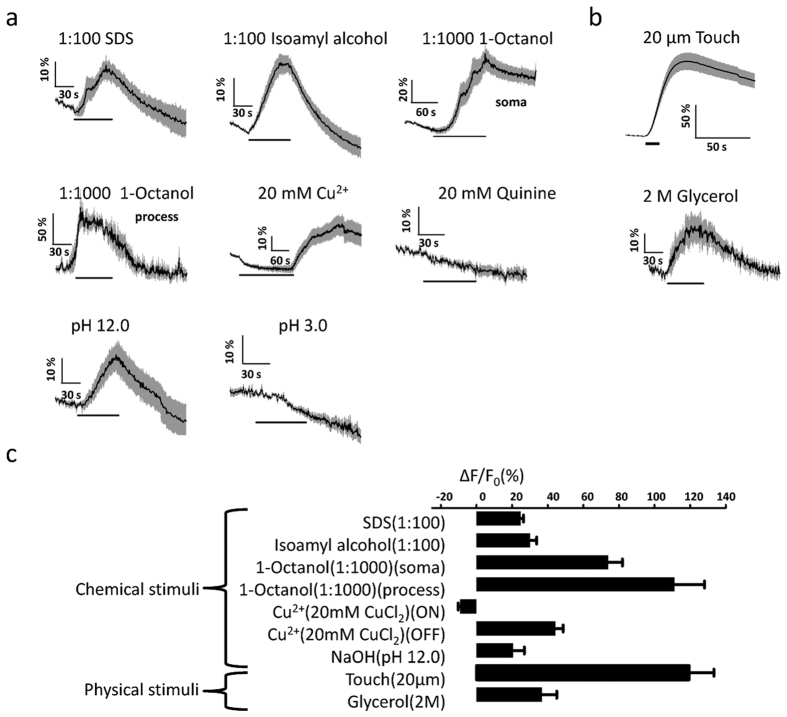
Noxious stimuli triggered calcium transients in the PHA/PHB neurons.(a) A variety of noxious chemical stimuli triggered calcium transients in the PHA/PHB neurons. The solid line shows the average fluorescence change and the shading around it indicate the ± SEM. Horizontal lines indicate the duration of application for each stimulus. Notably, 20 mM Cu2+ induced a decrease of calcium level in the PHA/PHB neurons. For 1-Ocanol induced-calcium elevations, both the soma and the progress were shown. (b) Calcium transients in the PHA/PHB neurons in response to physical stimuli. (c) Maximal calcium changes of the PHA/PHB neurons to the application of noxious stimuli. N > = 6 for each experiment, Data are mean ± SEM.